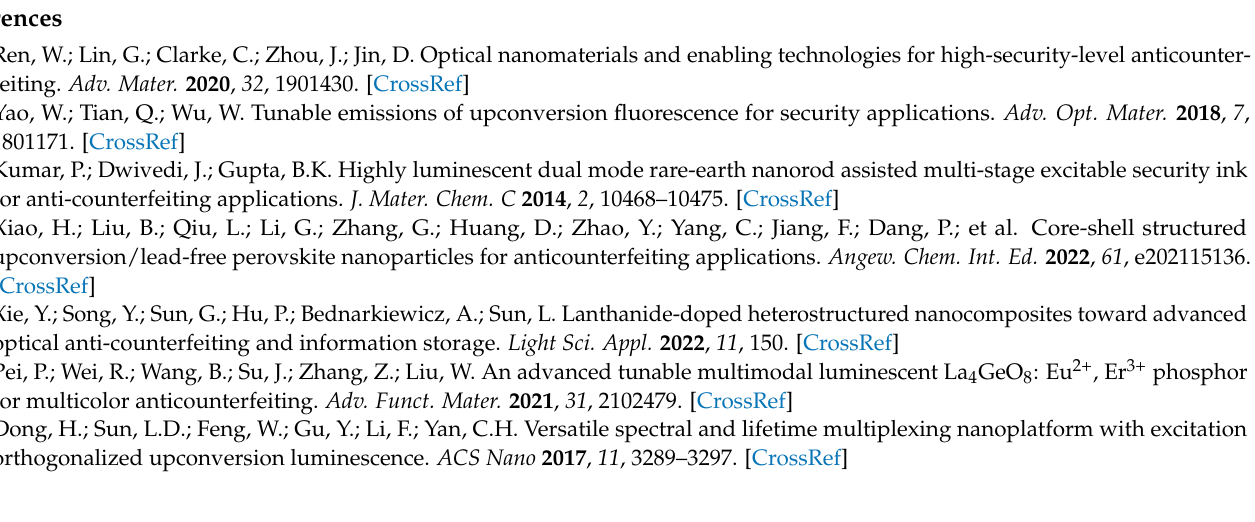
supporting figures including Figure S1: SEM images; Figure S2: XRD patterns; Figure S3: Simplified energy- level diagrams; Figure S4: UCL spectra; Figure S5: Double logarithmic plots; Figure S6: Color coordinates. Reference [26] is cited in the Supplementary